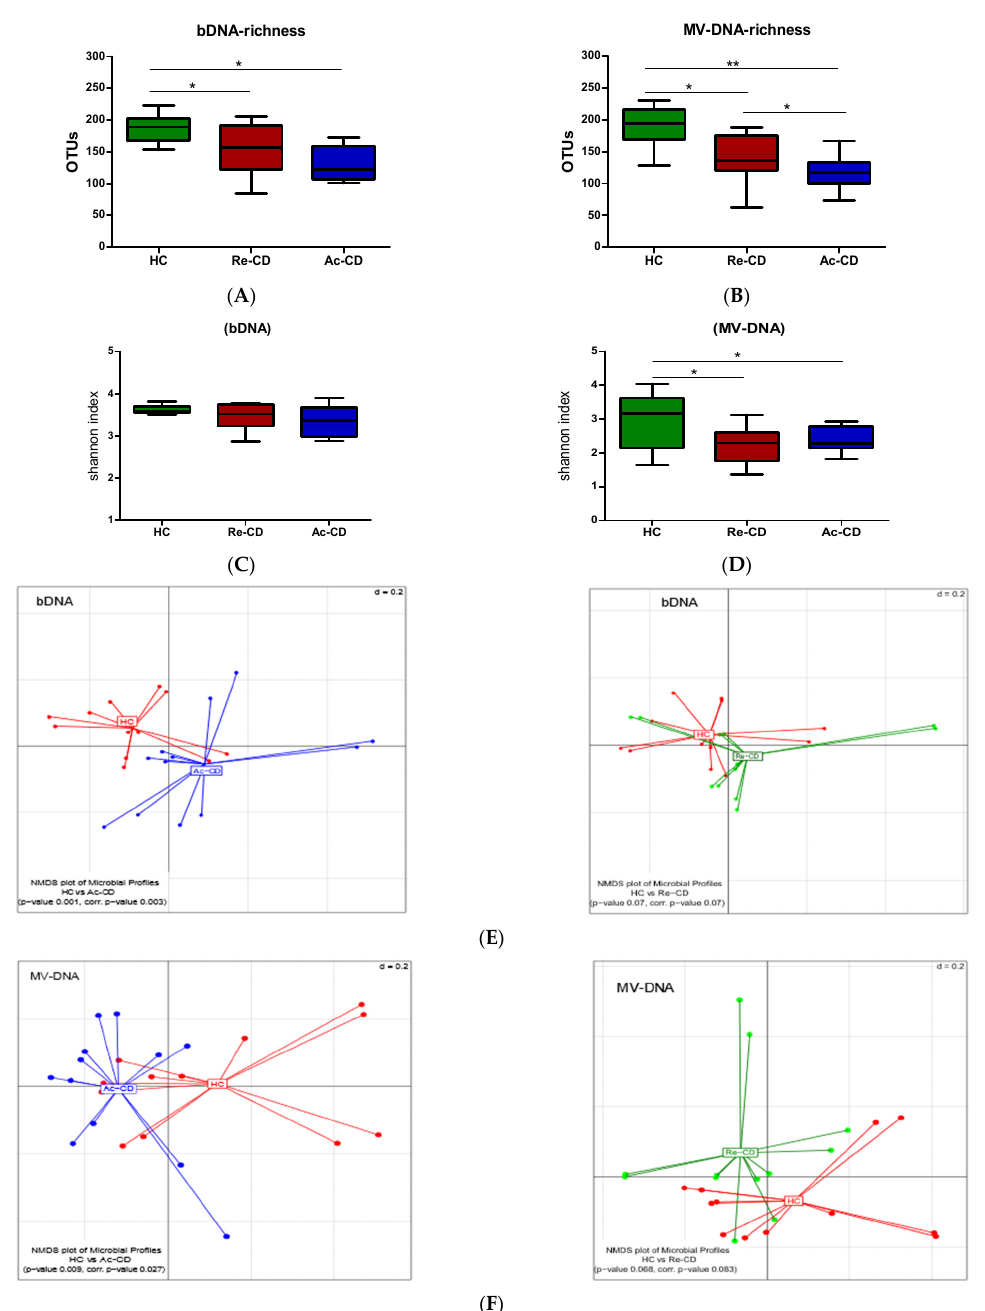
Figure 4. Microbial compositions and diversity of MV-DNA and bDNA of CD patients in comparison to HC (green: HC; red: Re-CD; blue: Ac-CD). ( A , B ) Microbial richness in bacterial DNA and MV DNA. ( C , D ) Alpha diversity as indicated by Shannon indices. ( E , F ) Beta diversity of microbial compositions: non-metric multidimensional scaling (NMDS) calculated from the generalized UniFrac dissimilarity matrix. Pairwise comparison revealed a significant distance between HC and Ac-CD in bacterial DNA ( E ) and vesicles DNA ( F ), the PER- MANOVA test used to determine the p -value. Results show as boxplots with whiskers. A Mann–Whitney test is used for statistics; p -value indicated as (* < 0.05, ** < 0.01).